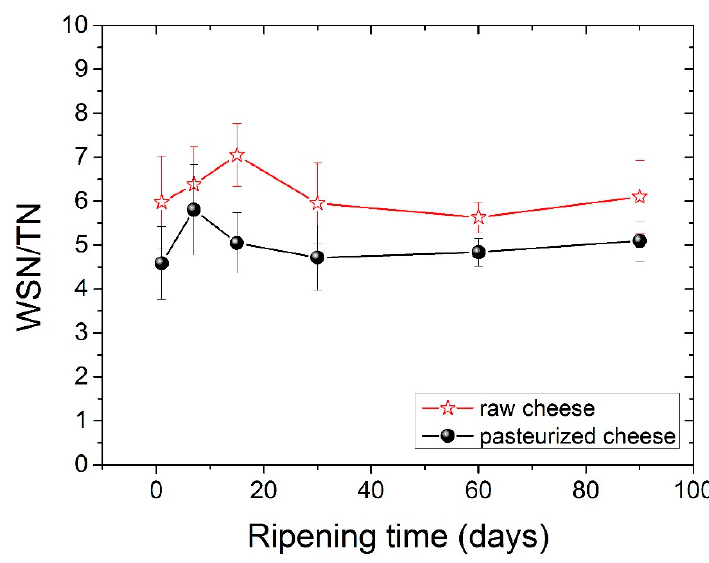
Figure 1. Ripening index (WSN/TN) for both types of cheese during ripening.